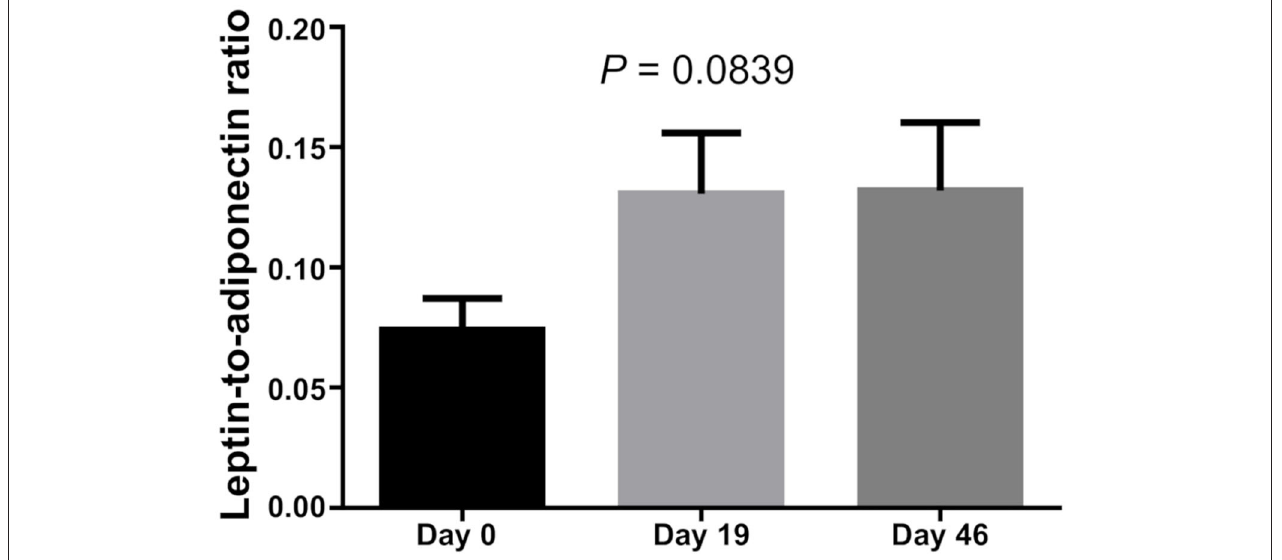
FIGURE 3 | Leptin/Adiponectin rate of bone marrow.